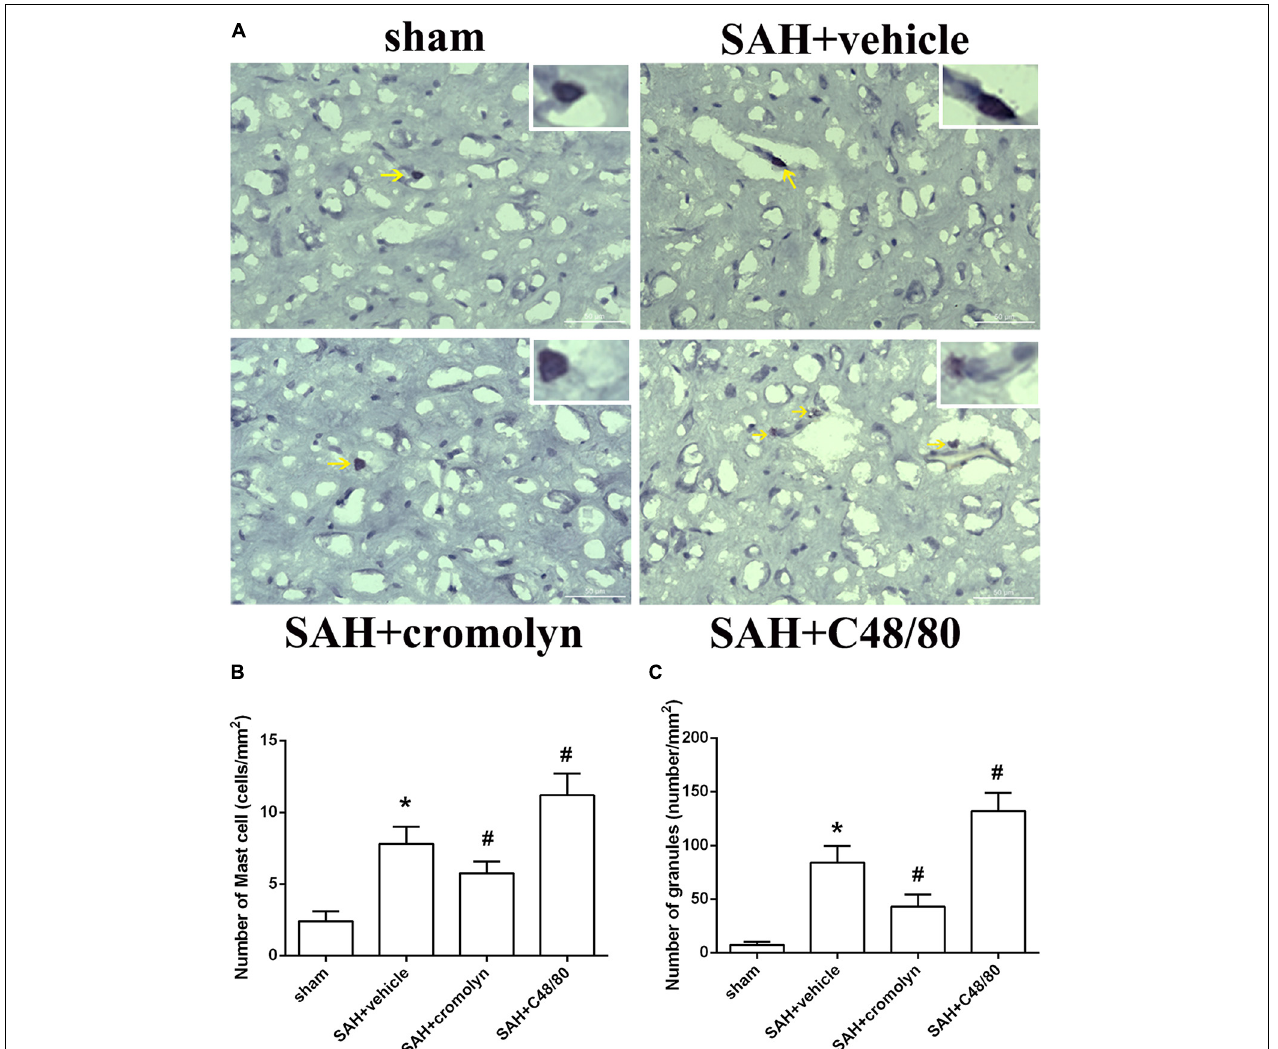
FIGURE 2 | Effect of cromolyn and compound 48/80 on MCs infiltration and degranulation at 24 h after SAH. (A) Toluidine blue staining of mast cells in cortex region (yellow arrow: infiltrated MCs). (B,C) Quantitative analyses of MCs infiltration and degranulation. n = 6. Data are represented as mean ± SD. * P < 0.05 versus sham group. # P < 0.05 versus SAH + vehicle